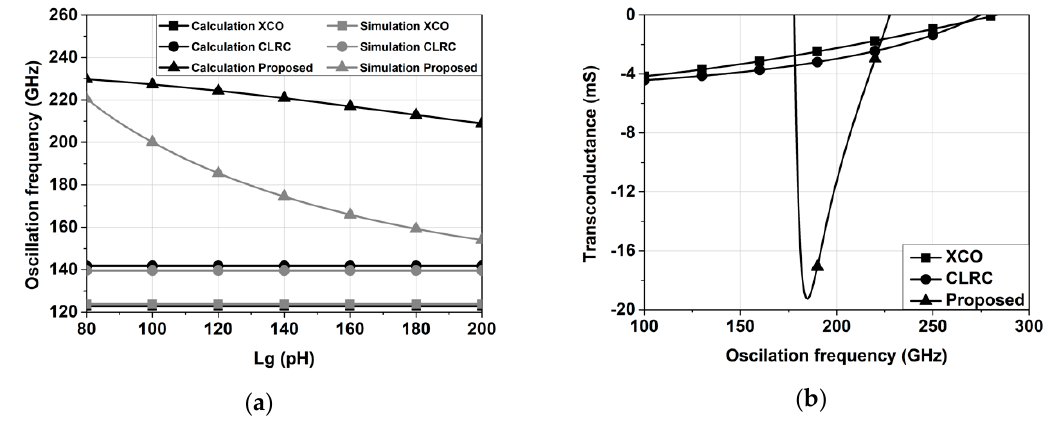
Figure 4. ( a ) Calculation and simulation results of oscillation frequency with various inductance values of L g ; and ( b ) simulation results of the negative transconductance of conventional XCO, XCO with CLRC, and the proposed oscillator.